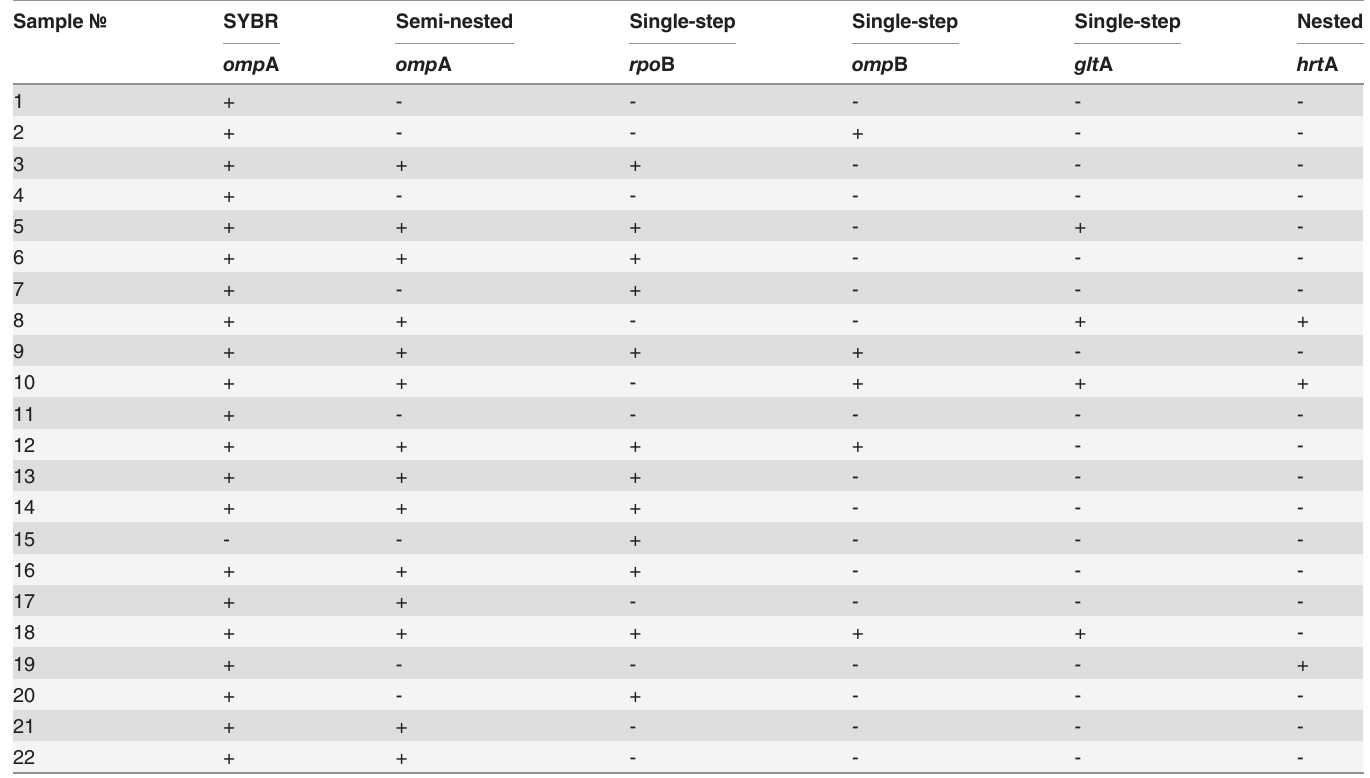
Table 4. Incongruence of PCR results performed by 5 conventional PCRs and real-time PCR on positive animal skin biopsy samples. Sample